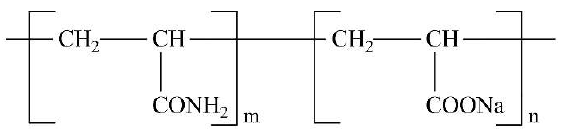
Figure 7. Structure of xanthan gum (XG) molecular chain [40].